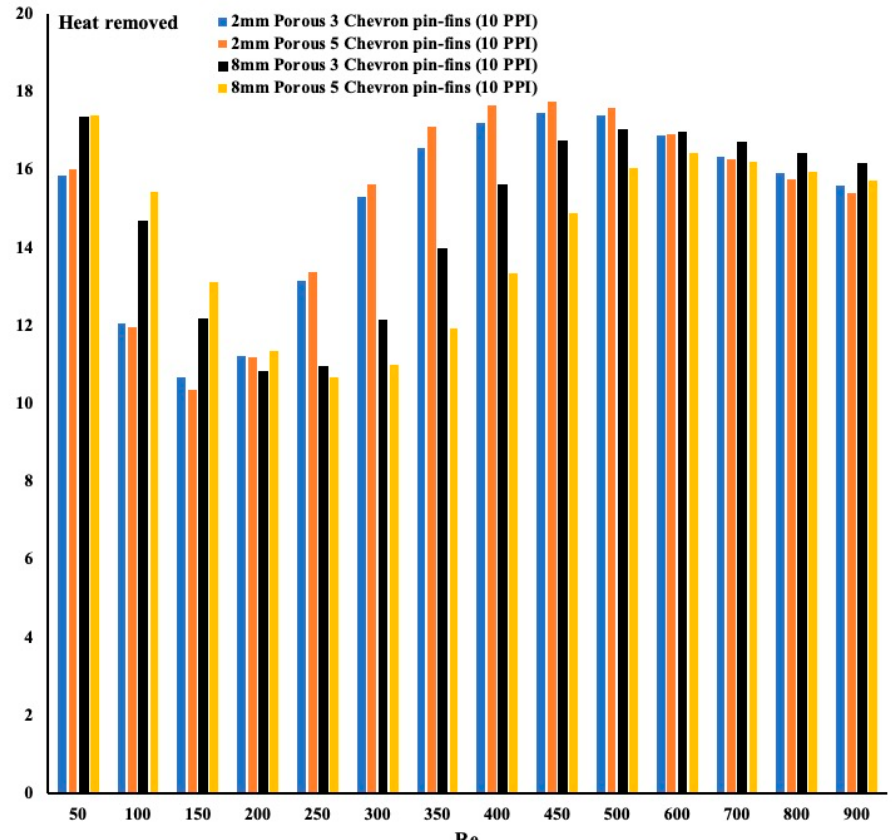
Figure 9. Heat removed using 10 PPI porous pin-fins.